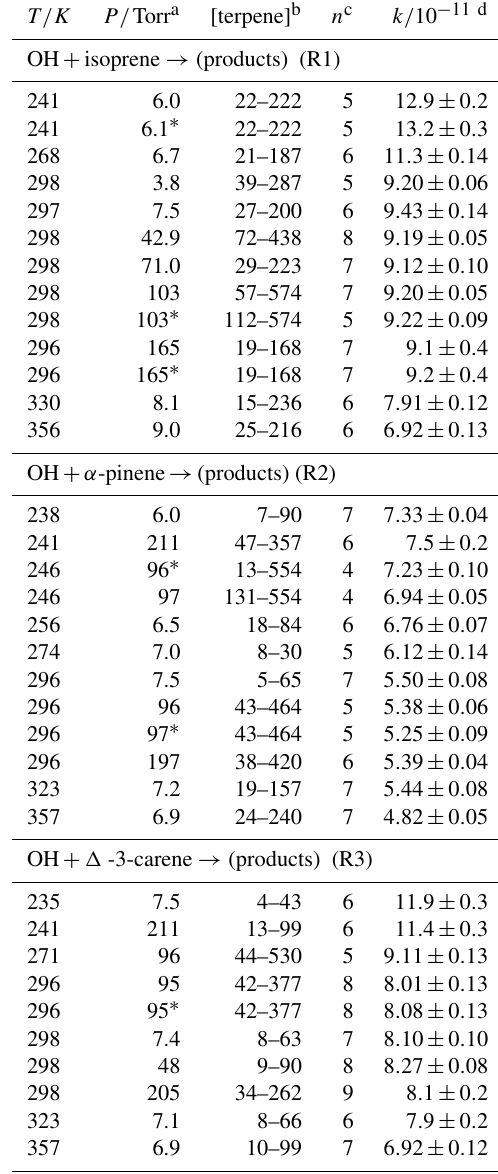
Table 2. Summary of rate coefficients k 1 , k 2 and k 3 determined in this